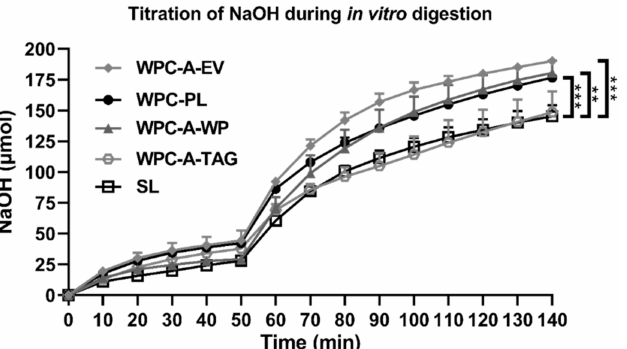
Figure 1. Titration of free fatty acids during simulated human gastric digestion with recombinant human gastric lipase (rHGL) and pepsin at pH 6.4 (0–50 min) and pH 6.5 (50–140 min) of 3.5% oil- in-water emulsions using either whey protein concentrate from acid whey-enriched in extracellular vesicles (WPC-A-EV) ( n = 3), WPC enriched in phospholipids (WPC-PL) ( n = 3), whey protein concentrate from acid whey enriched in triglycerides (WPC-A-TAG) ( n = 3), whey protein concentrate from acid whey enriched in soluble whey protein (WPC-A-WP) ( n = 3), and soy lecithin (SL) ( n = 2 due to removal of outliers). Values are presented as mean ± SD. ** p < 0.001. *** p <